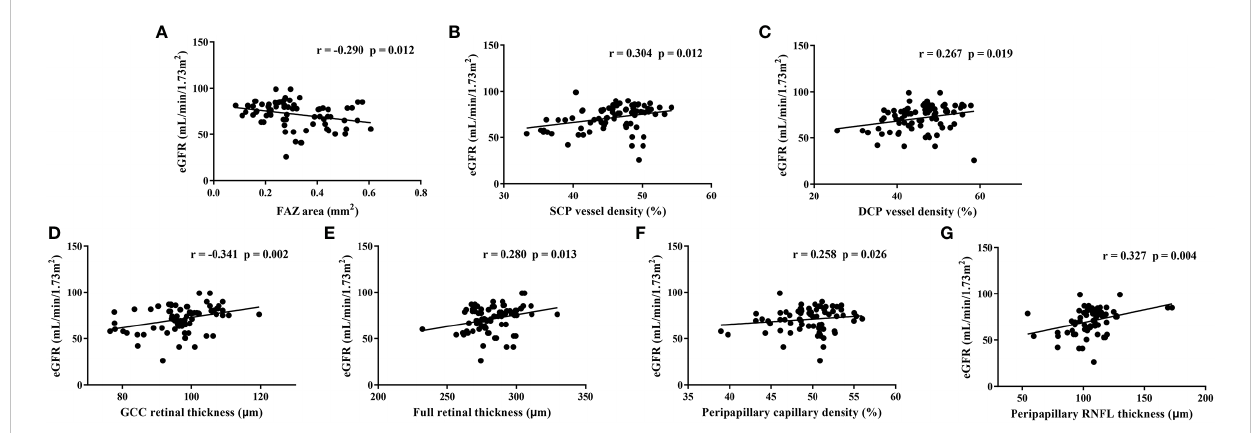
FIGURE 2 Relationships between estimated glomerular fi ltration rate (eGFR) and each representative optical coherence tomography angiography parameter in all individuals. FAZ: foveal avascular zone, SCP, super fi cial capillary plexus; DCP, deep capillary plexus; GCC, ganglion cell complex; RNFL, retinal nerve fi bre layer; r, Pearson correlation coef fi